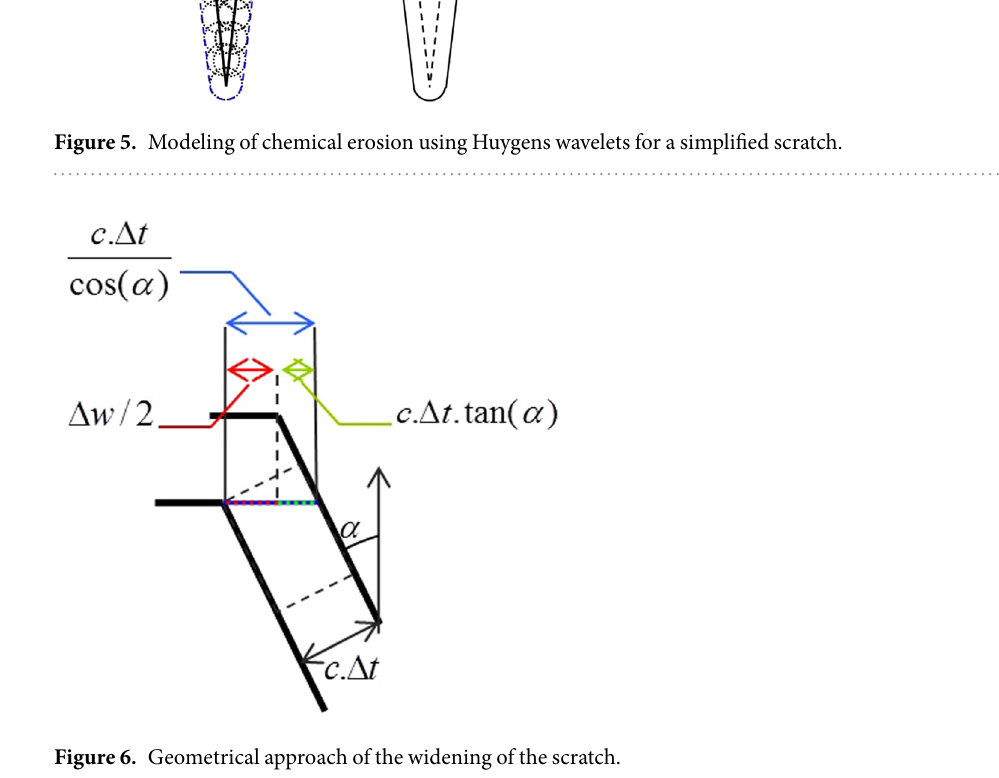
Figure 6. Geometrical approach of the widening of the